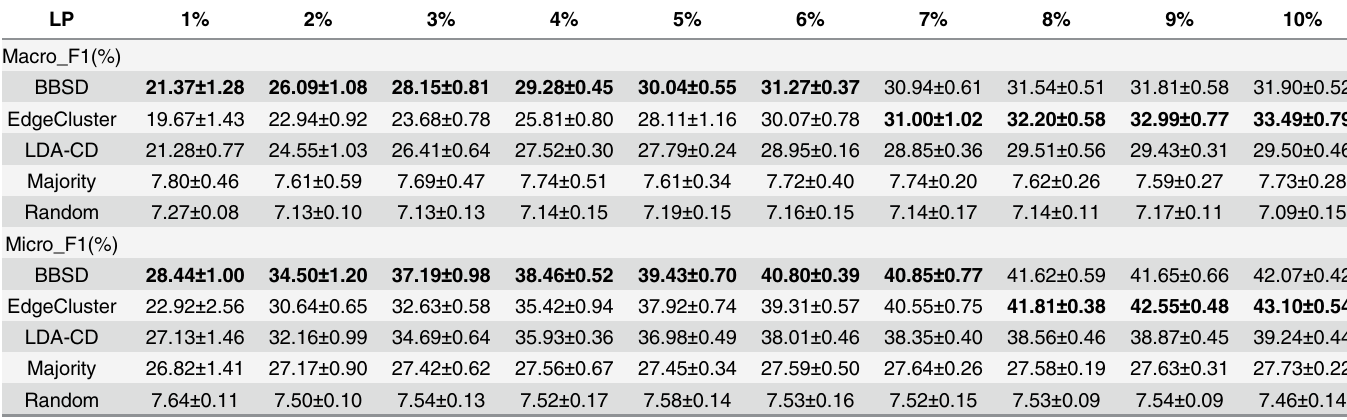
Table 3. Classification performance on YouTube